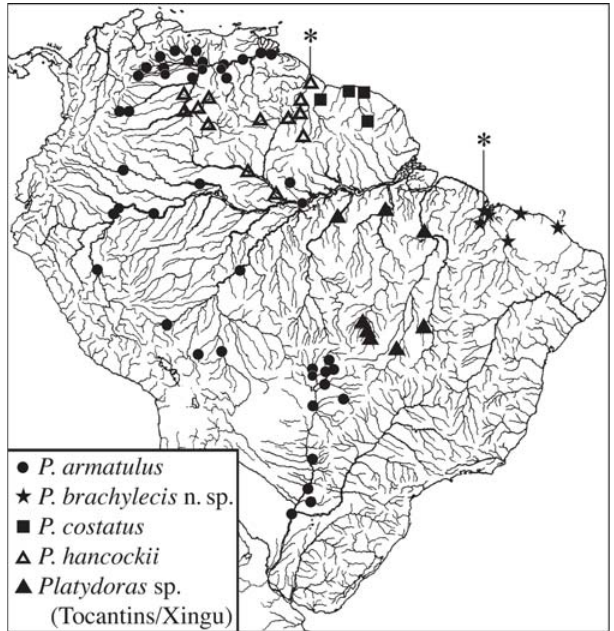
Fig. 5. Distribution of specimens of Platydoras examined. Type localities denoted with asterisk except for Platydoras armatulus (= Brazil, Paraná, not below 27°30’S) and P. costatus (= likely Suriname). ? = locality data questionable. Base map by M.